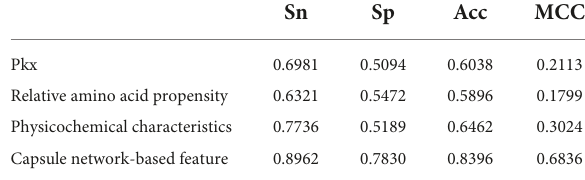
TABLE 6 Performance comparison across different features by linear discriminant analysis (LDA). Sn